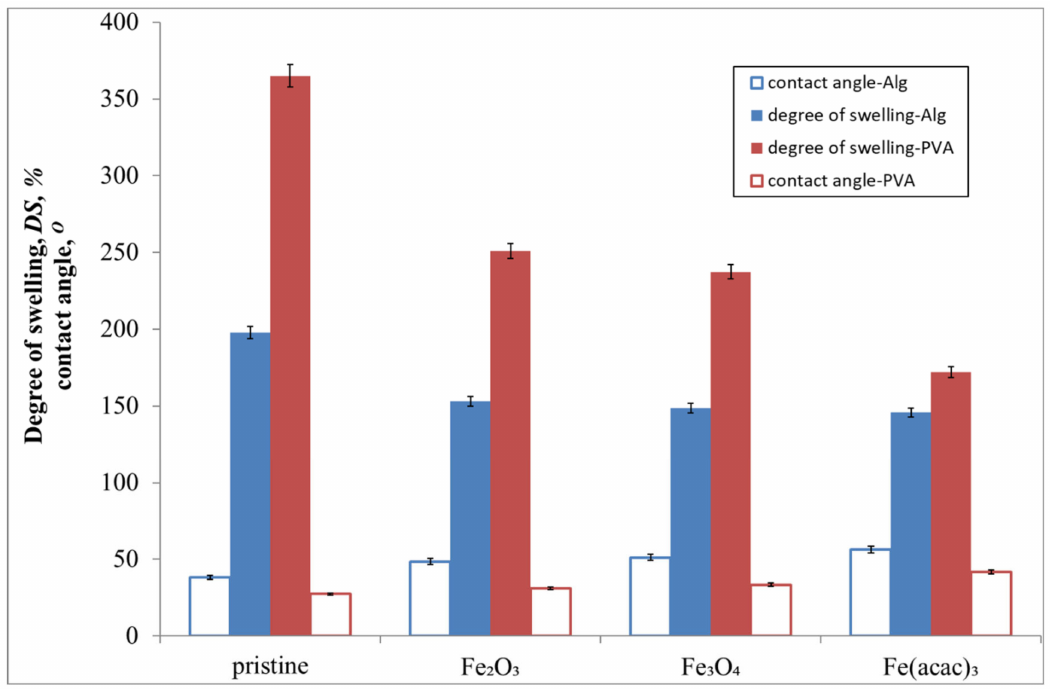
Figure 3. Average contact angles θ (n = 10) and degree of swelling DS (n = 10) of plain and hybrid composite PVA and ALG membranes filled with 15 wt% of di ff erent iron-based